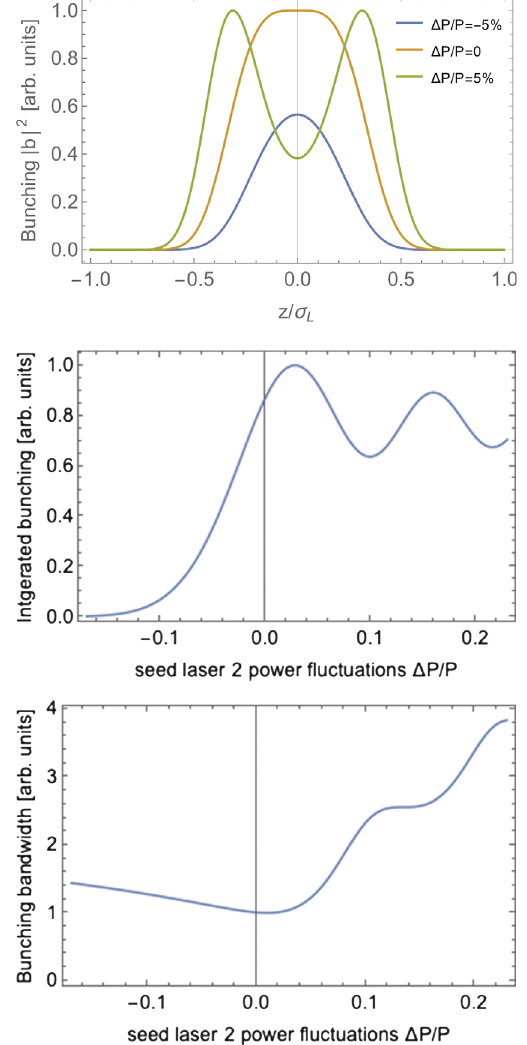
FIG. 11. Effects of intensity fluctuations in the second EEHG laser from theory for h ¼ 130 . The temporal bunching profile becomes split by over-modulation (top), which enables multi- color seeding through interference between the two phase-locked pulses. The integrated bunching power (middle), and the bunch- ing bandwidth (bottom) vary